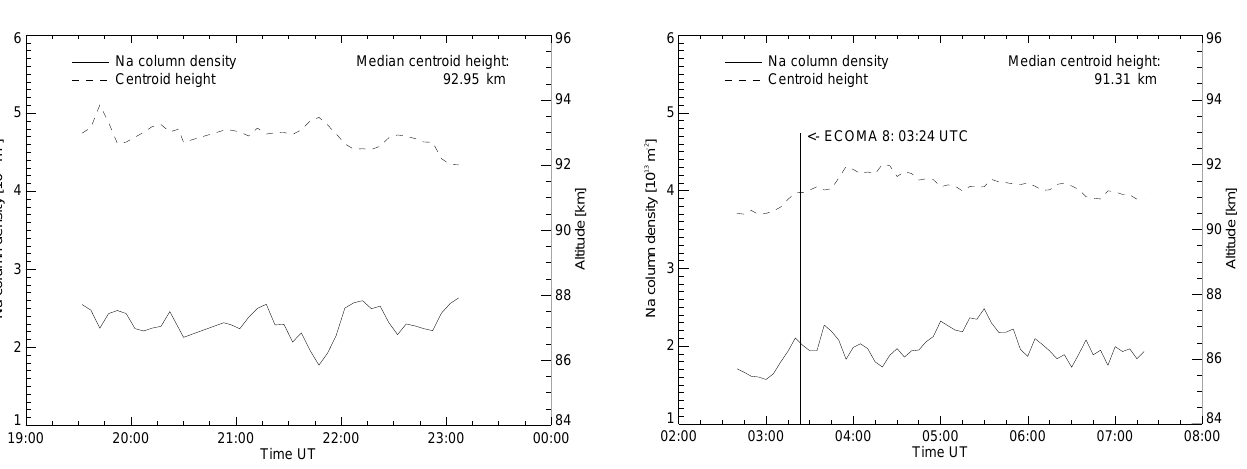
Fig. 3. Time series of Na column density for the northward pointing beam on 4 December 2010. The temporal resolution is five minutes.